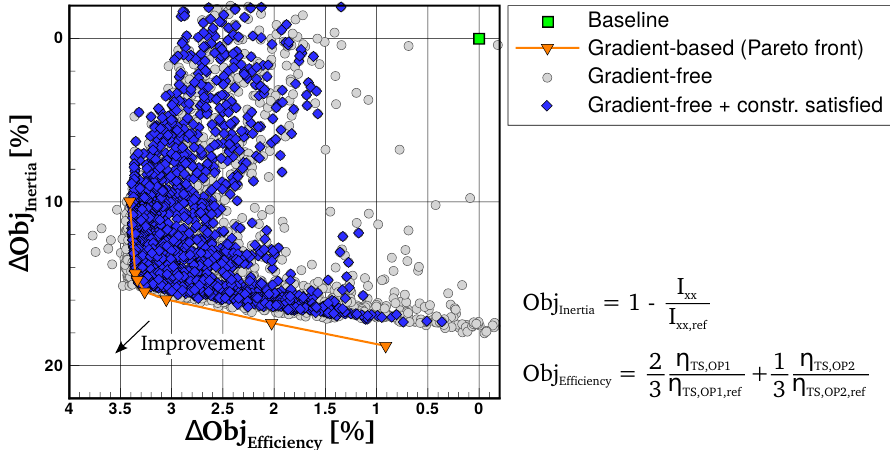
Figure 11. Close-up on the Pareto front in the objective space after 200